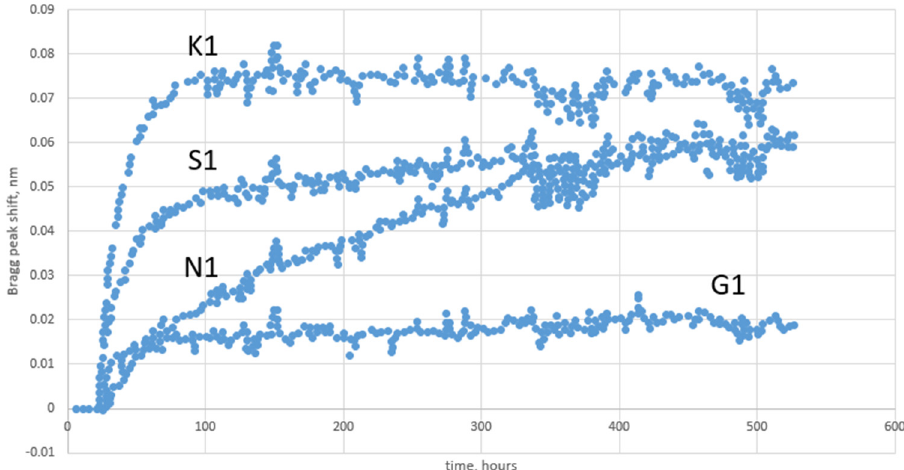
Figure 16. Shift of the Bragg peak under gamma radiation for different FBGs, adapted from [142].